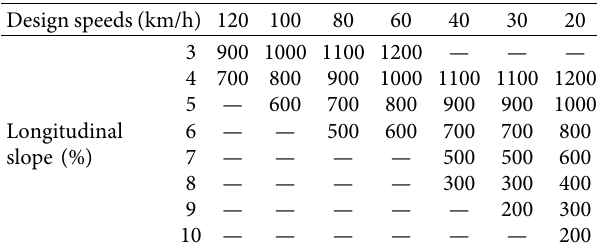
Table 9: Maximum length of a highway slope (unit: m).